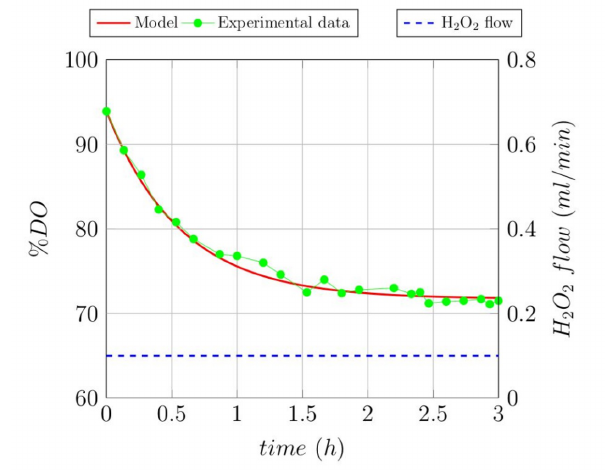
Figure 3. Degradation of lignin during the Open-Loop experiment.